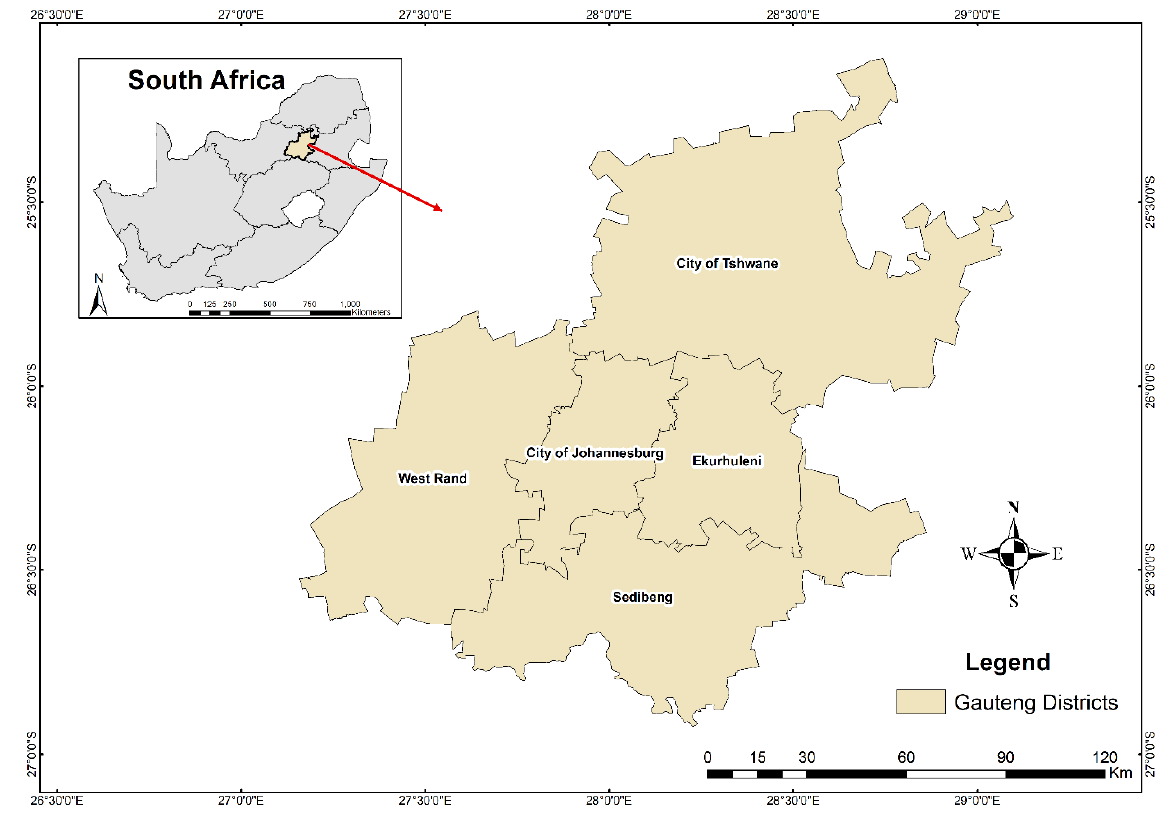
Figure 1. Map showing the position of Gauteng Province and its five districts.